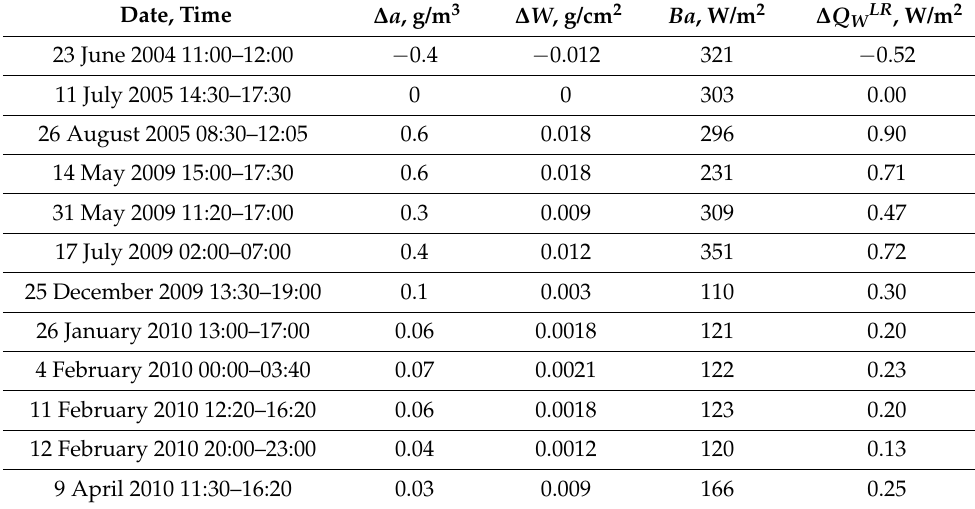
Table 5. Estimates of ∆ Q WLR from measurements of the mobile